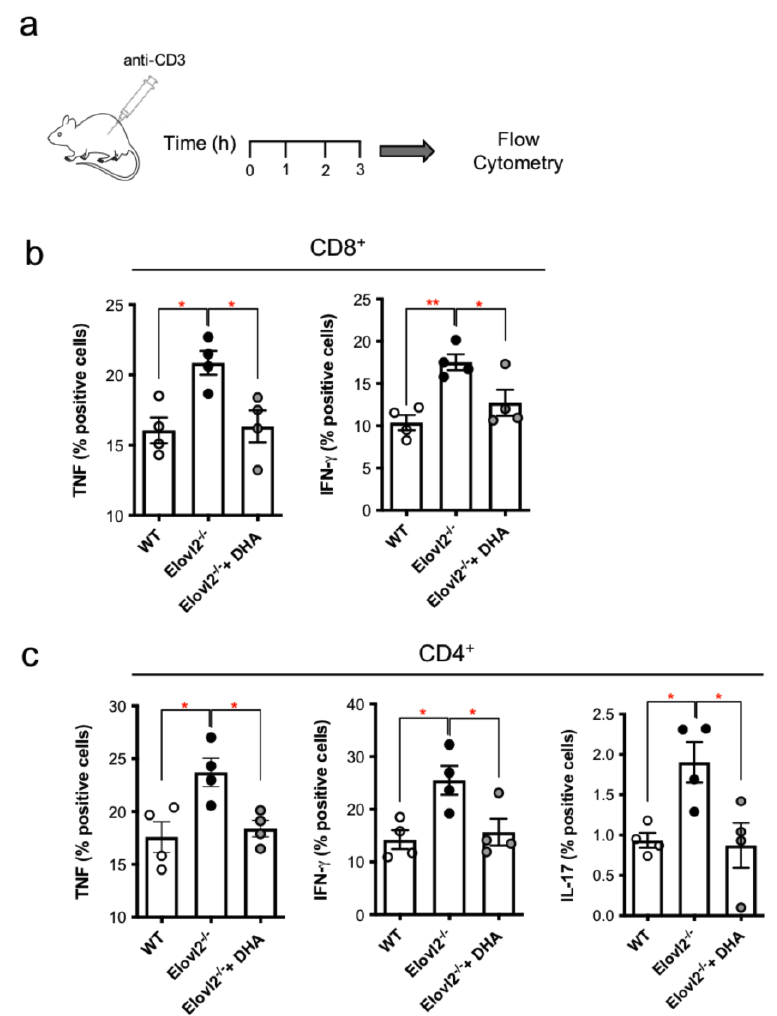
Figure 3. ( a ) Schematic representation of the experimental design in vivo; ( b ) histograms of intracellular TNF- α and IFN - γ production from CD8+ following in vivo injection of anti-CD3 in WT, cellular TNF- α and IFN- γ production from CD8+ following in vivo injection of anti-CD3 in WT, Elov2 −/− and Elov2 −/− + DHA. ( c ) histograms of intracellular IFN- γ and IL -17 production from CD4+ Elov2 − / − and Elov2 − / − + DHA. ( c ) histograms of intracellular IFN- γ and IL-17 production from following in vivo injection of anti-CD3 in WT, Elov2 −/− and Elov2 −/− + DHA. * p < 0.05; ** p < 0.01. CD4+ following in vivo injection of anti-CD3 in WT, Elov2 − / − and Elov2 − / − + DHA. * p < 0.05; ** p <